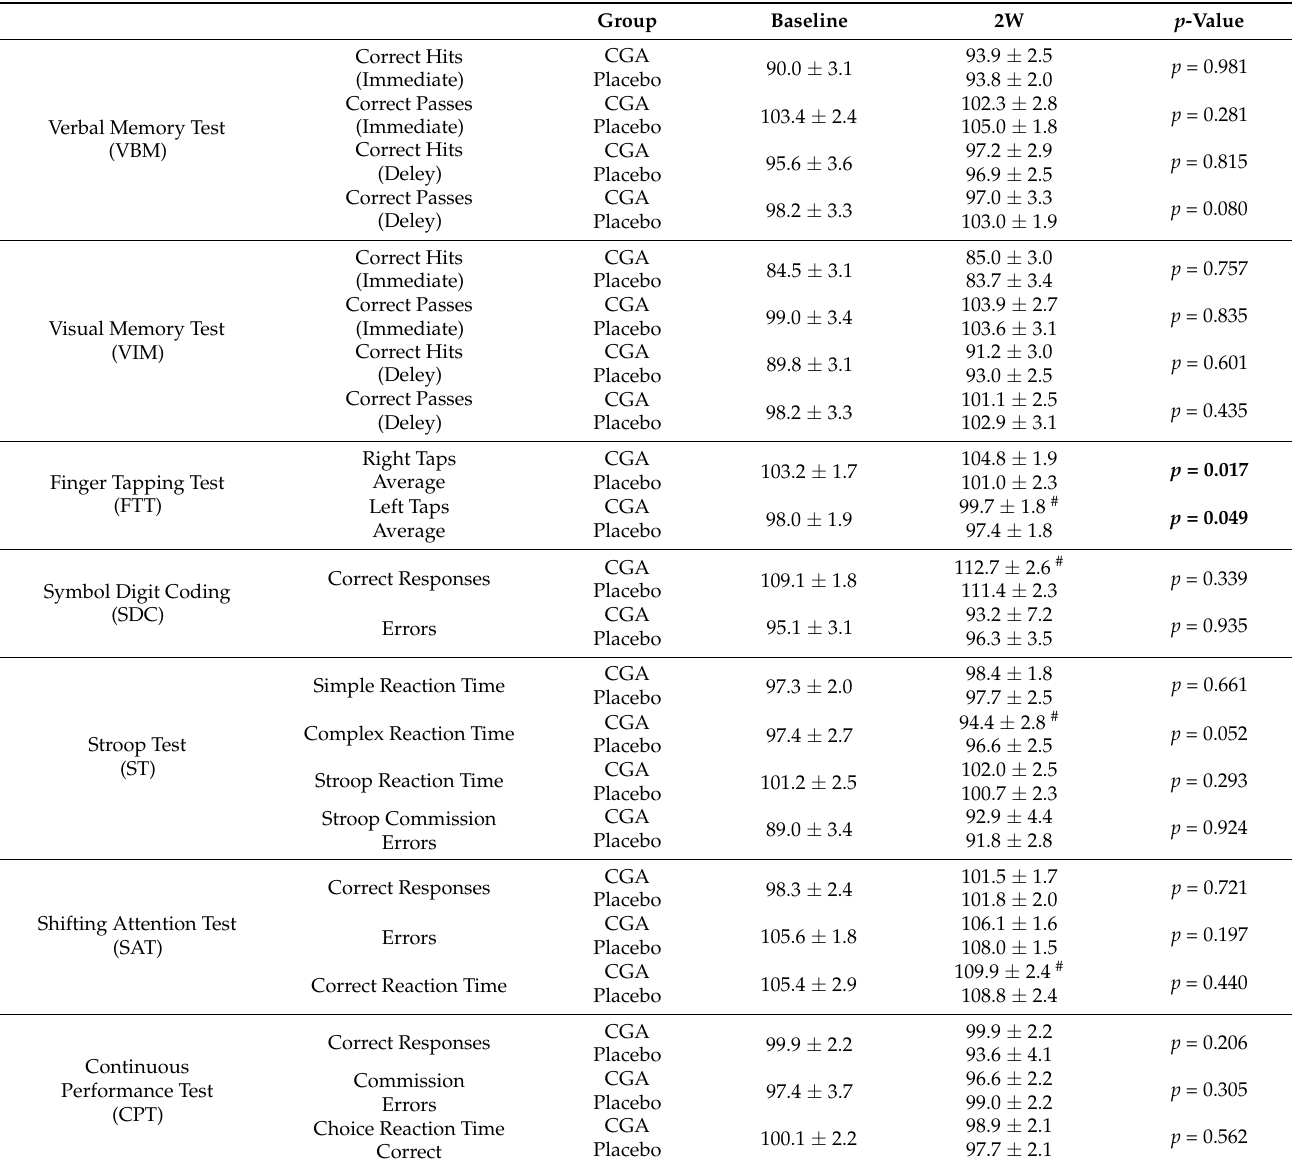
Table 3. The standardized scores of individual tests in Cognitrax. Group Baseline 2W p